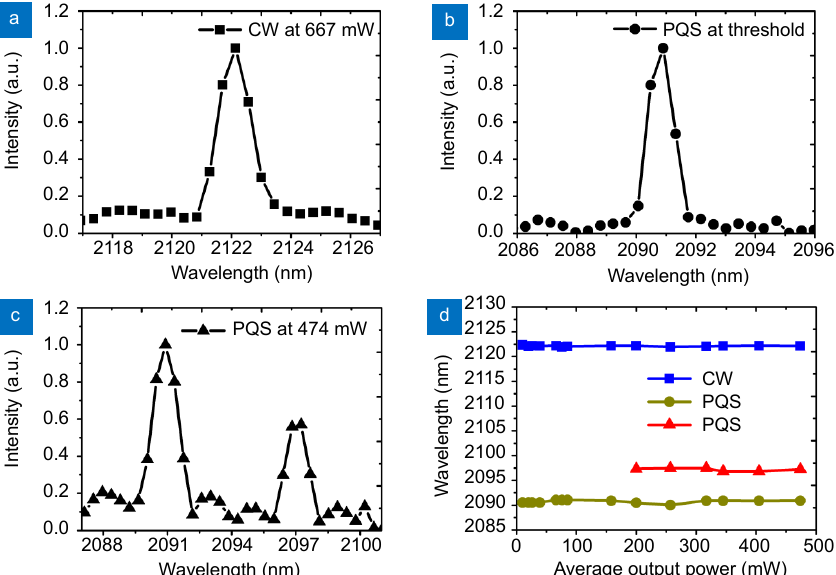
Fig. 6 | Wavelength properties of the Tm/Ho composite laser : ( a ) at the maximum free-running (CW) laser power; ( b ) at the threshold PQS laser power of 20 mW; ( c ) at the maximum PQS laser power; ( d ) the measured peak wavelengths at different average output power.